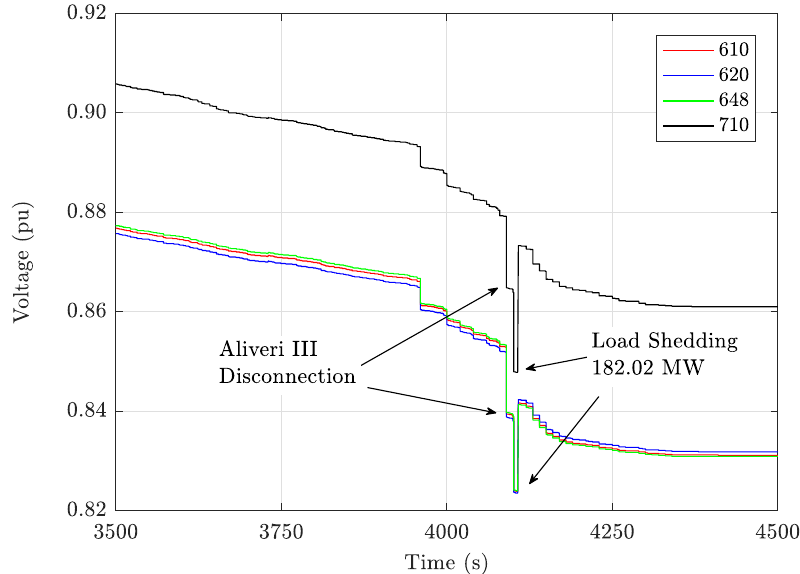
Figure 13. Voltage response at EHV buses 610 (Acharnon), 620 (Koumoundourou), 648 (Ag. Stefanos) and HV bus 710 (Rouf) with the use of the proposed SPS and a load shedding of